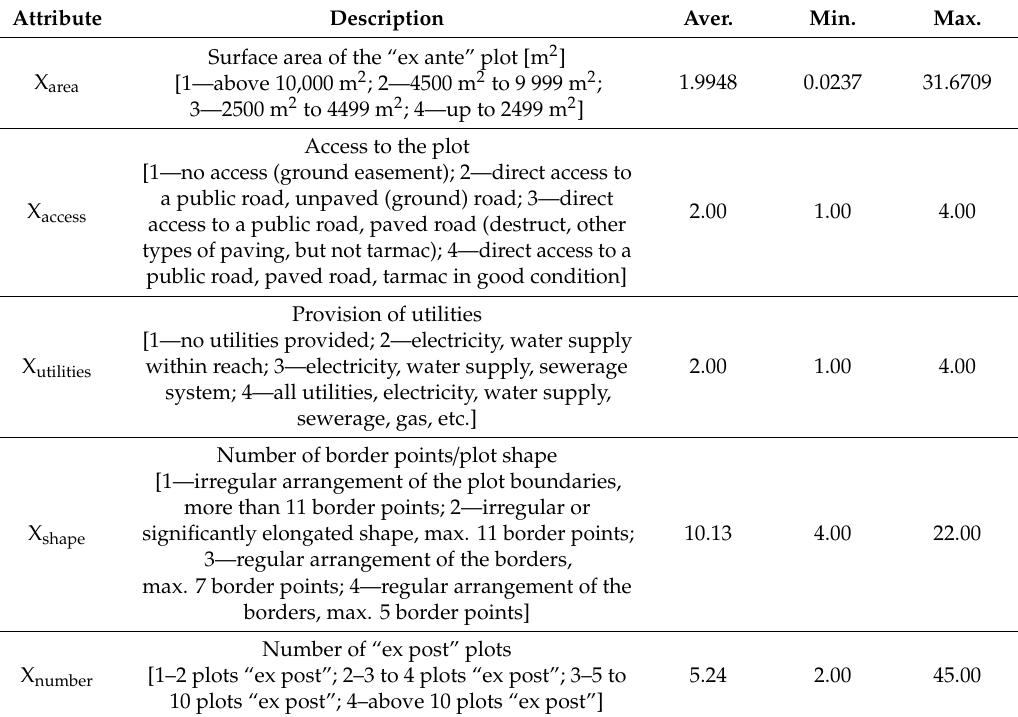
Table 1. Basic statistics of the data of the model together with the attribute